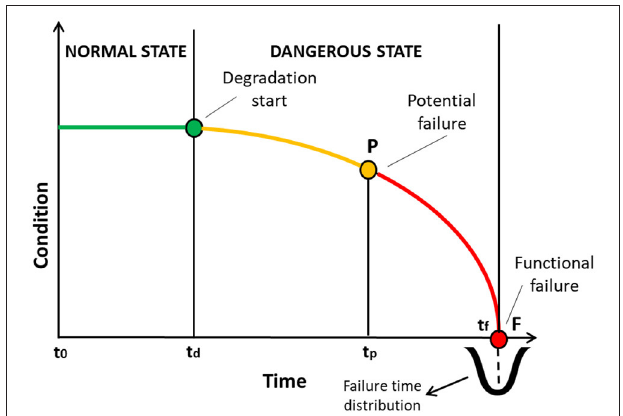
FIGURE 5 | Predictive maintenance in the context of the P-F curve.